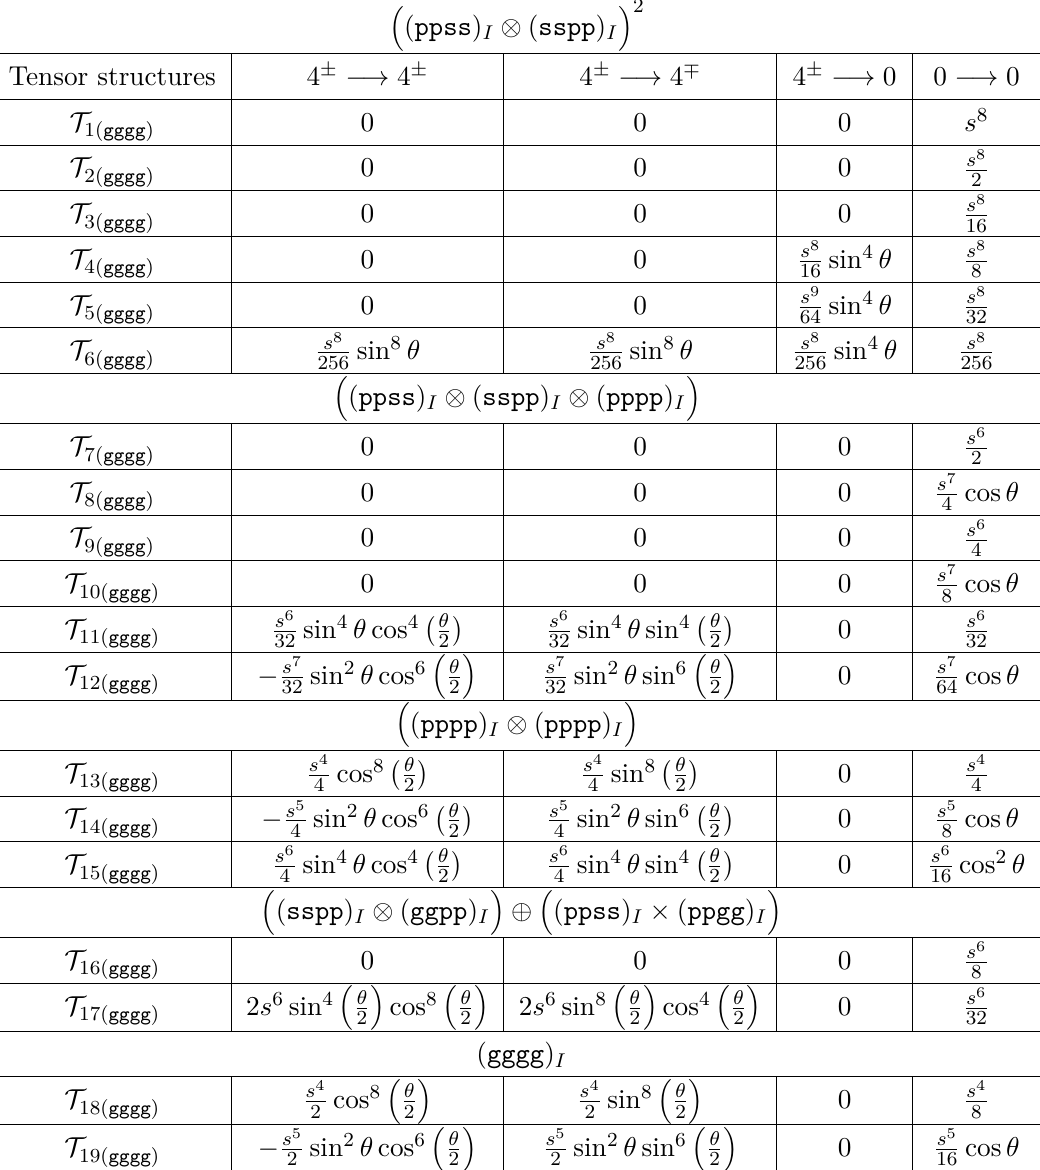
Table 5 . Angular distributions for different gggg tensor